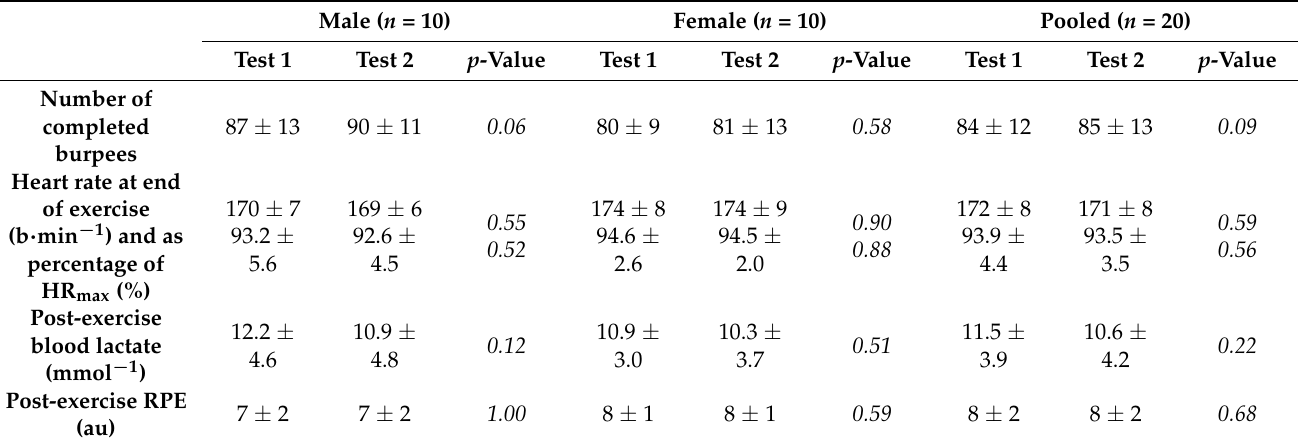
Table 2. Part I (reliability): Descriptive statistics of number of burpees completed and physiological responses during the 3-min burpee test (3-MBT) between Test 1 and Test 2 in male and female athletes.